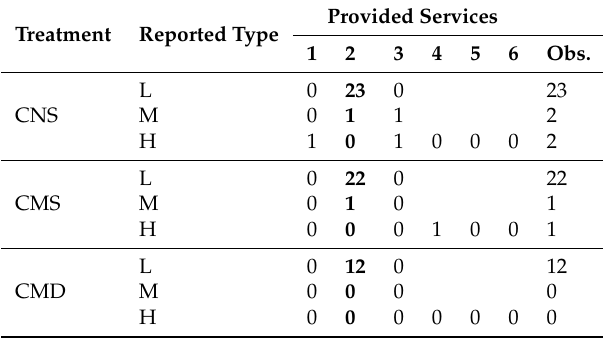
Table A12. Reporting and provision of medical services for Type L Patients